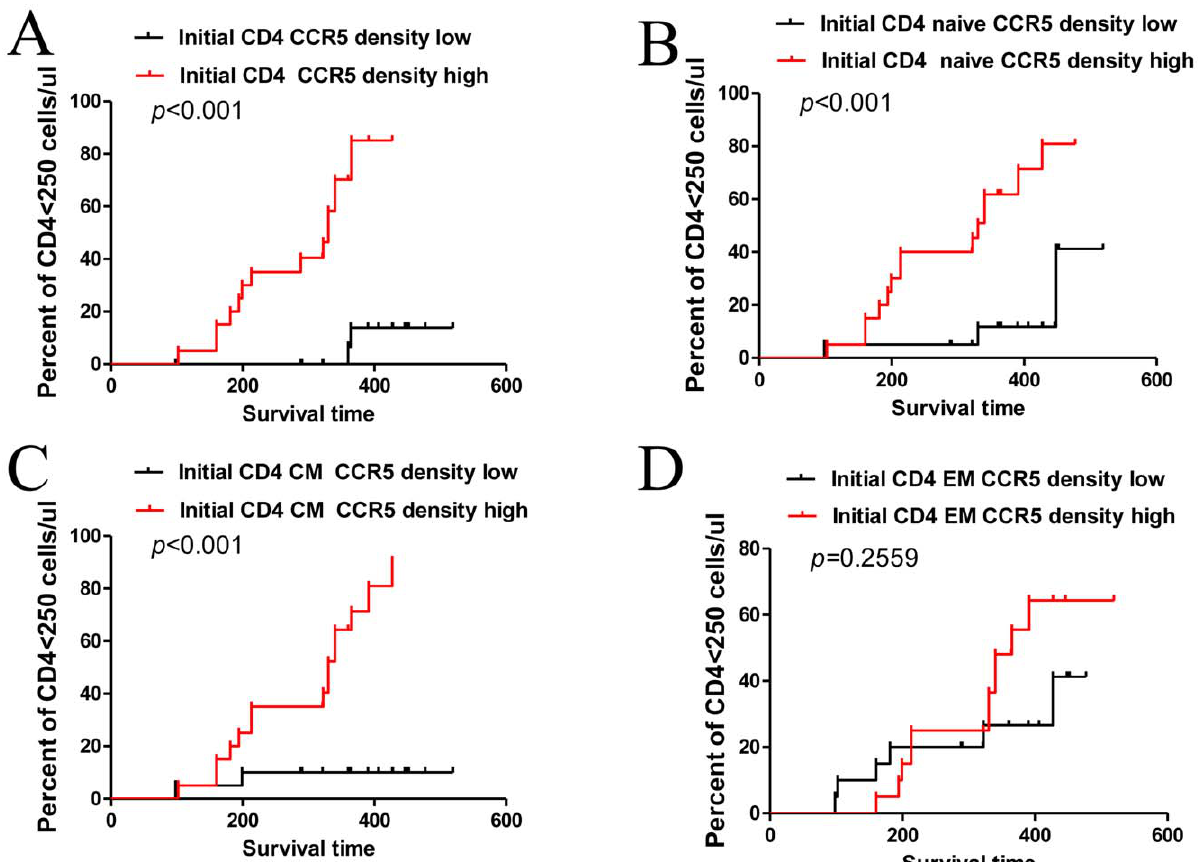
Figure 4. Analysis the association between initial CCR5 expression on CD4 subsets and the time for CD4 , 250 cells/ul. Initial CCR5 expression on CD4(A), naı¨ve(B) and CM(C) were associated with the time taken for the study participants’ CD4 counts to fall below 250 cells/ m l. There was no obvious association between initial CCR5 expression on EM with the time taken for the study participants’ CD4 counts to fall below 250 cells/ m l.